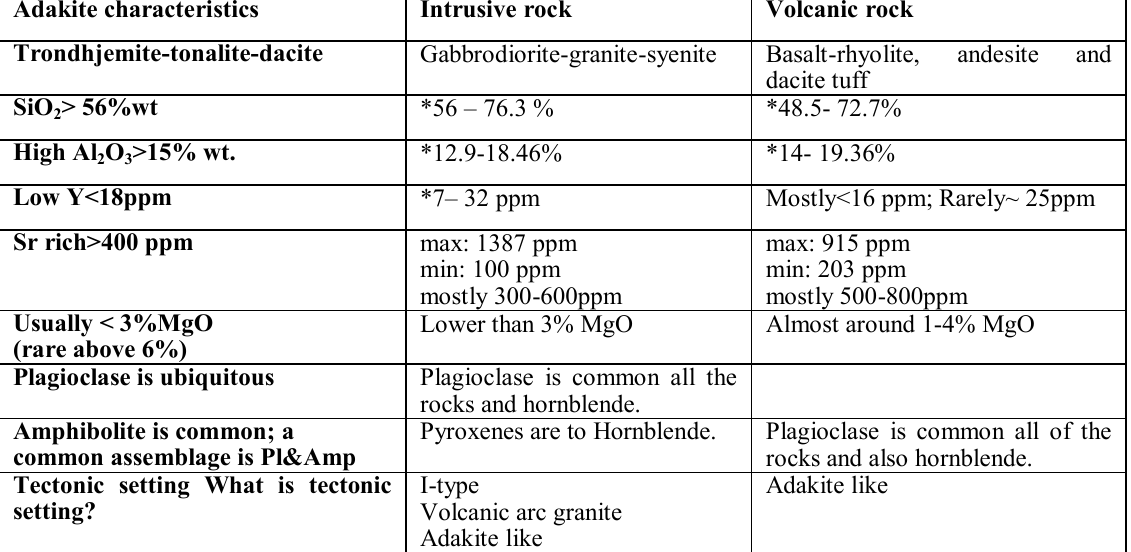
Table 5. Carboniferous magmatic rocks of the Mandakh area compared to